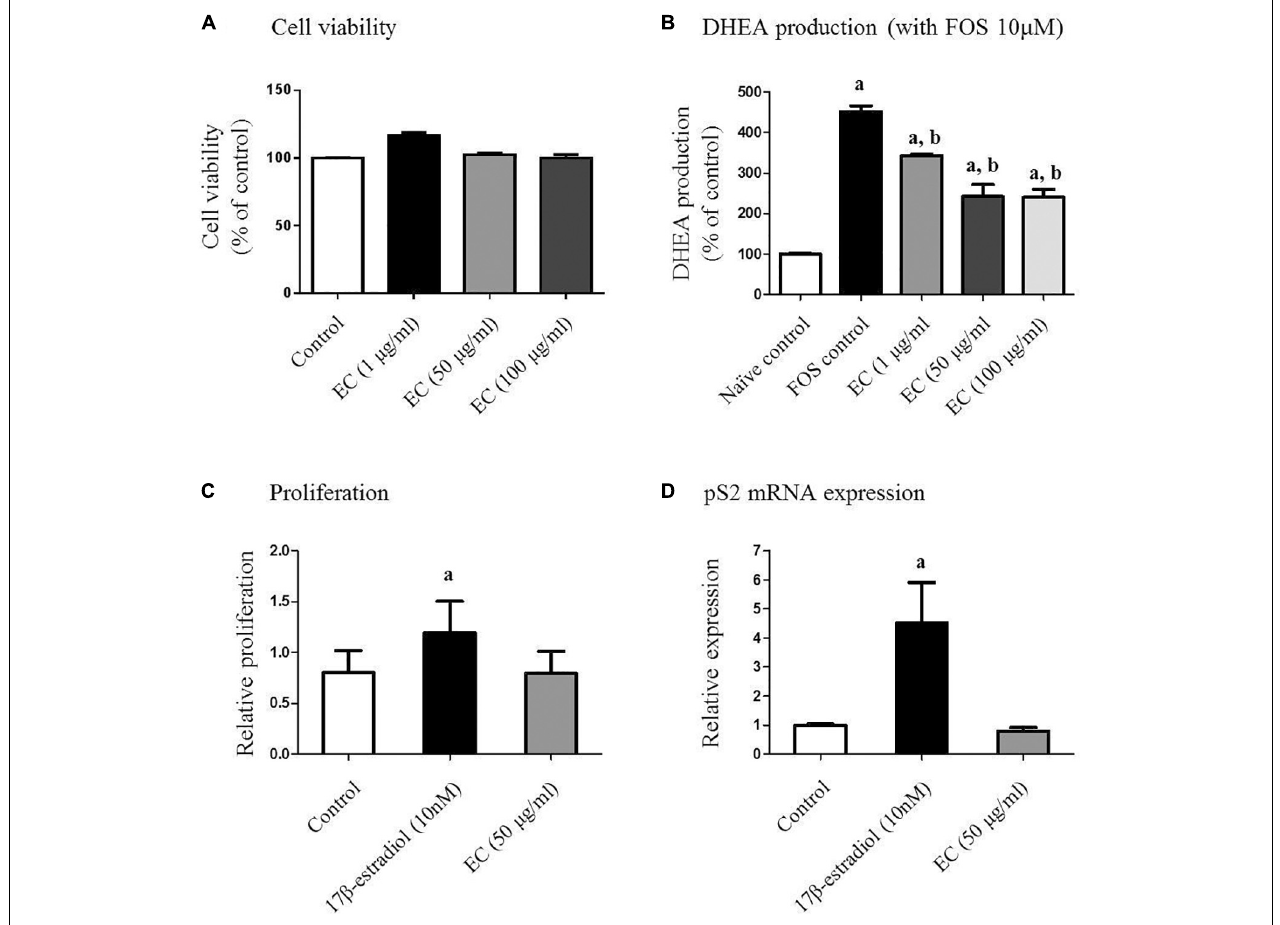
FIGURE 1 | Effect of E. cava extract on human adrenal NCI-H295R cells (A,B) and MCF-7 cells (C,D) . (A) NCI-H295R cells were incubated in the presence of the indicated concentrations of E. cava extract for 24 h. Cell viability was determined using the 3-(4,5-dimethylthiazol-2-yl)-2,5-diphenyltetrazolium bromide (MTT) assay and measurement of absorbance at 540 nm. (B) Cells were pretreated with E. cava extract (1, 50, and 100 µ g/mL) for 30 min prior to exposure to 10 µ M forskolin (Sigma-Aldrich) for 24 h. DHEA production was measured in cell culture medium by a competitive enzyme-linked immunosorbent assay following the manufacturer’s recommendations. Data are representative of three independent experiments and are expressed as the mean ± SD; a p < 0.05 vs. control; b p < 0.05 vs. forskolin. (C) MCF-7 cell proliferation and (D) pS2 gene expression were examined after treatment with estrogen and E. cava extract in estrogen-free medium (phenol red-free DMEM with 2% charcoal:dextran-stripped bovine serum) for 48 h. Data are representative of three independent experiments and expressed as the mean ± SD; a p < 0.05 vs. control. EC, E. cava extract; PCOS, polycystic ovary